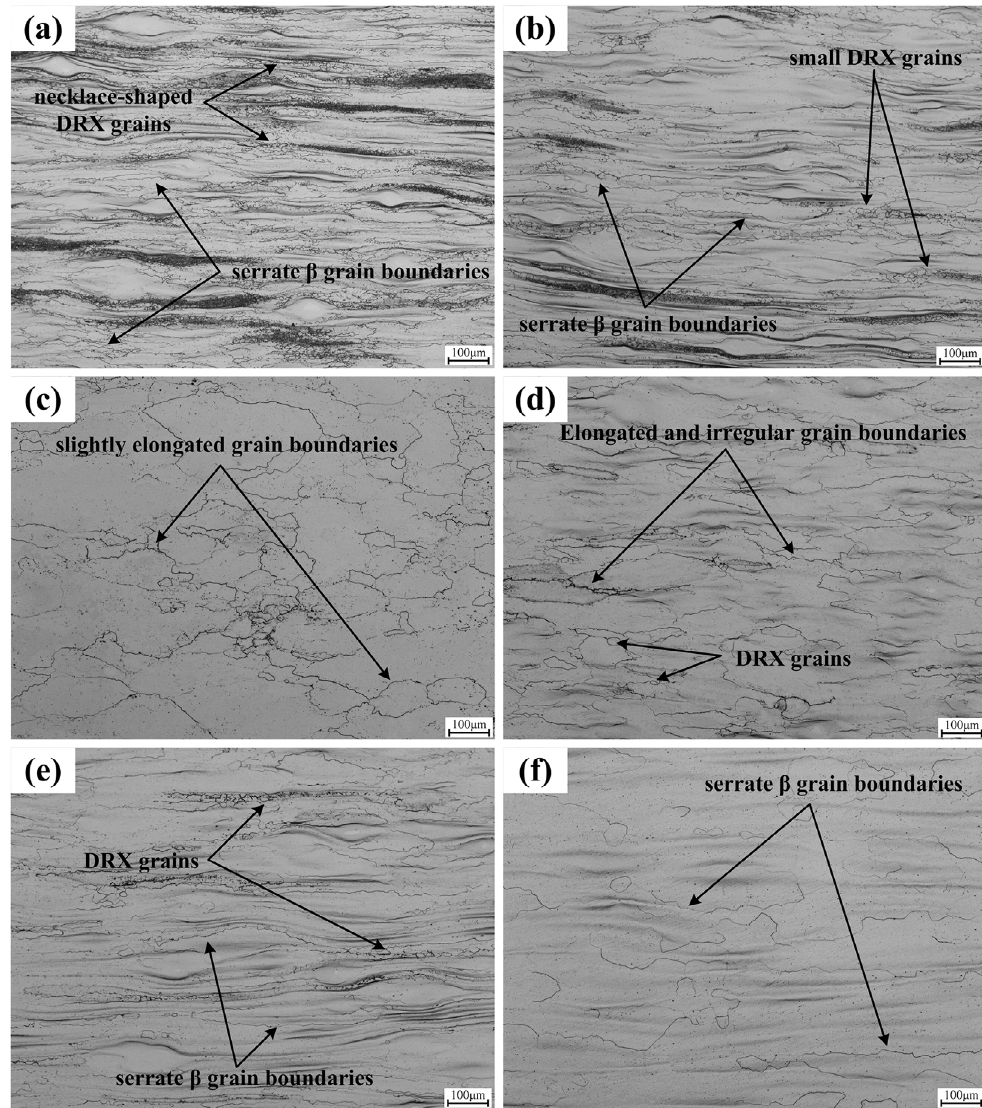
Figure 6. Optical microstructures of deformed PM Ti-5553 alloy subjected to various temperatures and deformation strain at 1 s -1 near the β transus and in β region: (a) 950 °C, 70%; (b) 1000 °C, 70%; (c) 1050 °C, 30%; (d) 1050 °C, 50%; (e) 1050 °C, 70%; and (f) 1150 °C,